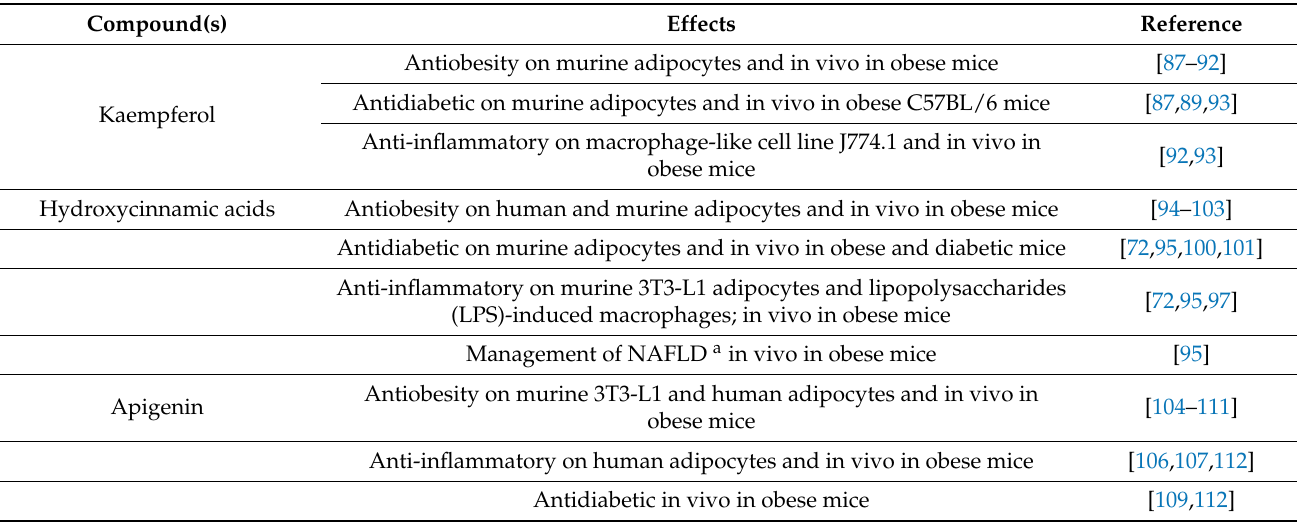
Table 3. Summary of main laurel leaf polyphenols’ effects on adipose